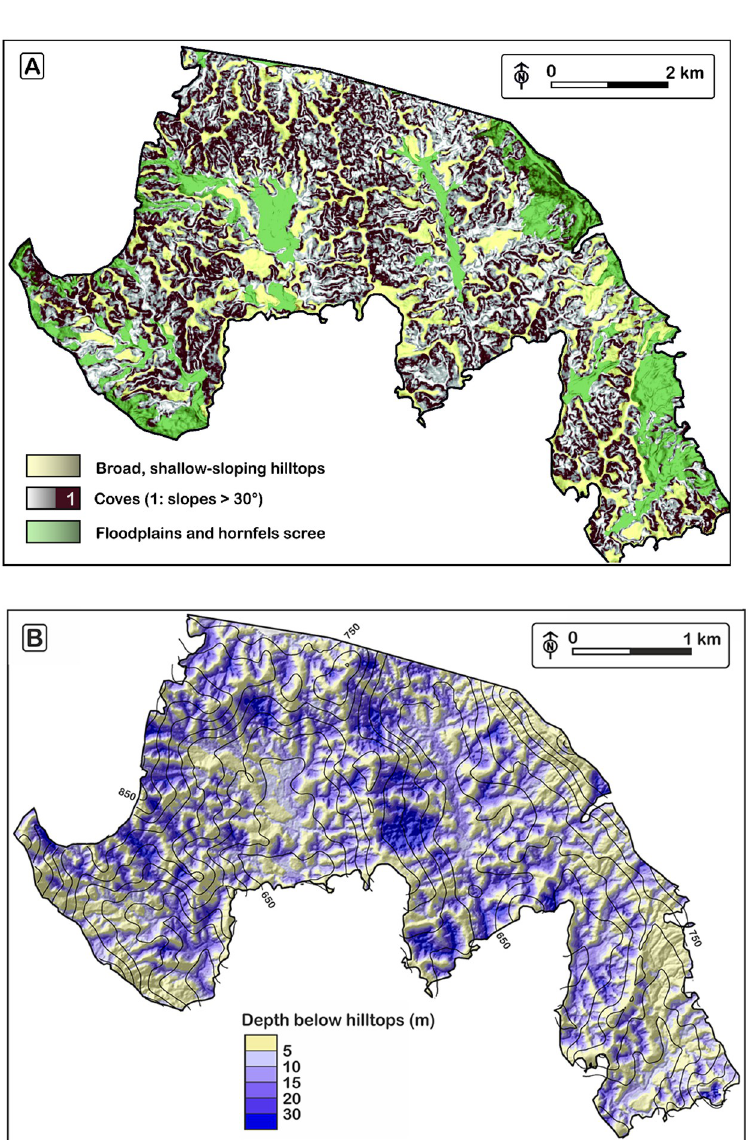
Fig 3. Maps of the mesoscale topography. A: Map of slopes steeper than the landslide threshold (30˚), used to delineate cove walls. HF: hornfels (silicified volcanoclastics). B: Depth of incision of the coves below the shallower landscape represented by broad low-curvature hilltops (yellow). Black solid contour lines (spacing 25m): elevation of the surface enveloping the broad hilltops. (Fig 4E, r 2 = 0.90). They highlight the propensity of the Palm forest to occupy coves, while the Palo Colorado forest covers hilltops.